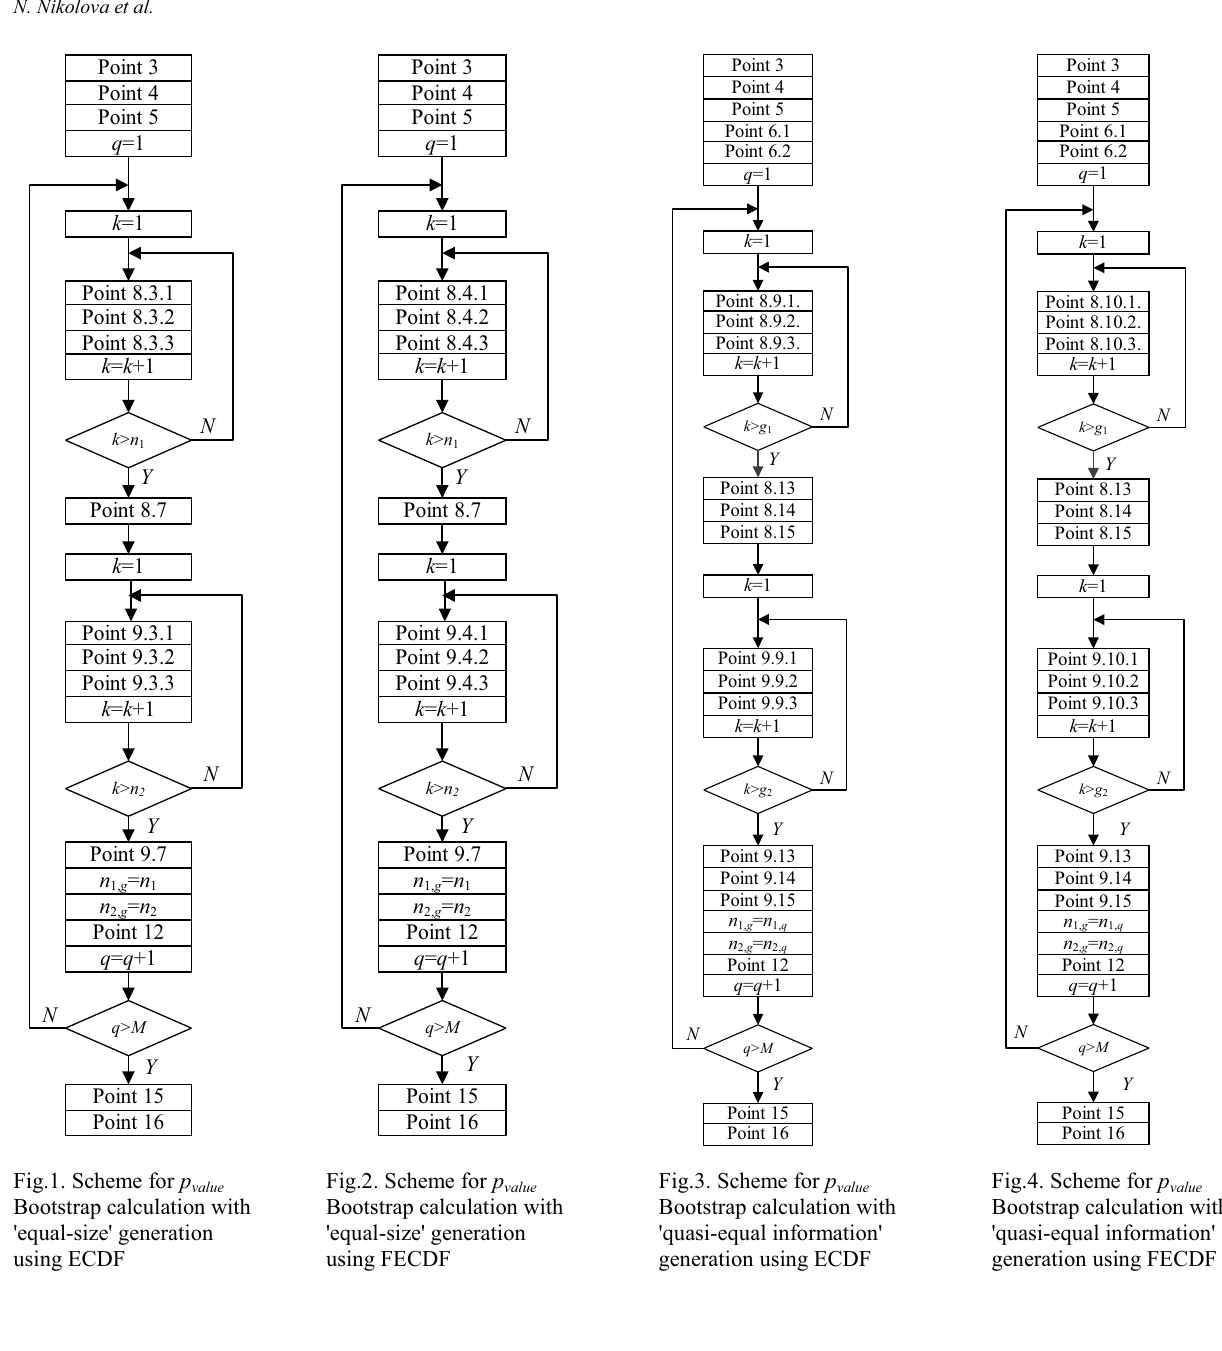
Fig.1. Scheme for p value Bootstrap calculation with